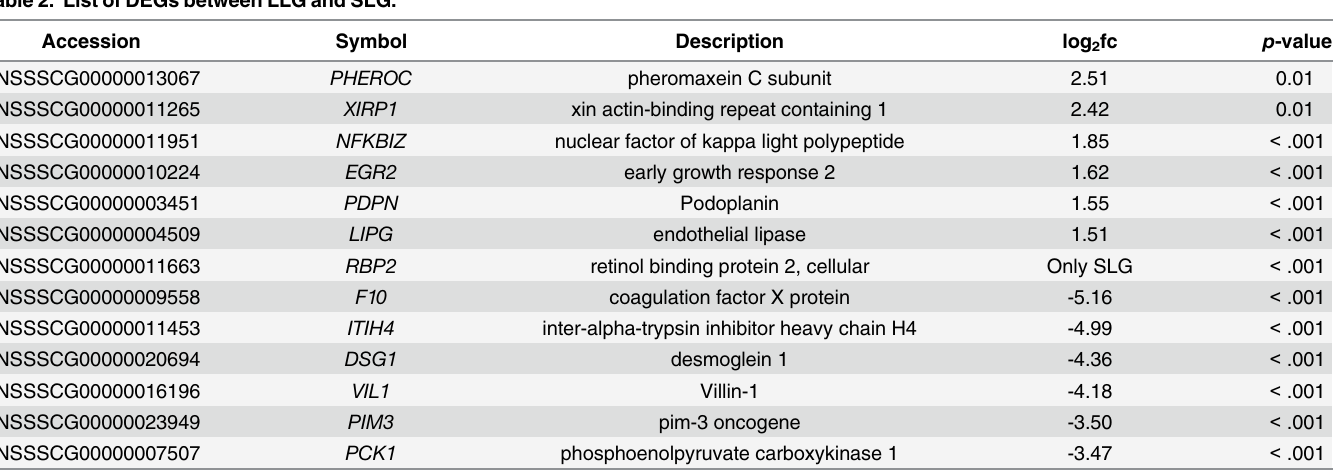
Table 2. List of DEGs between LLG and